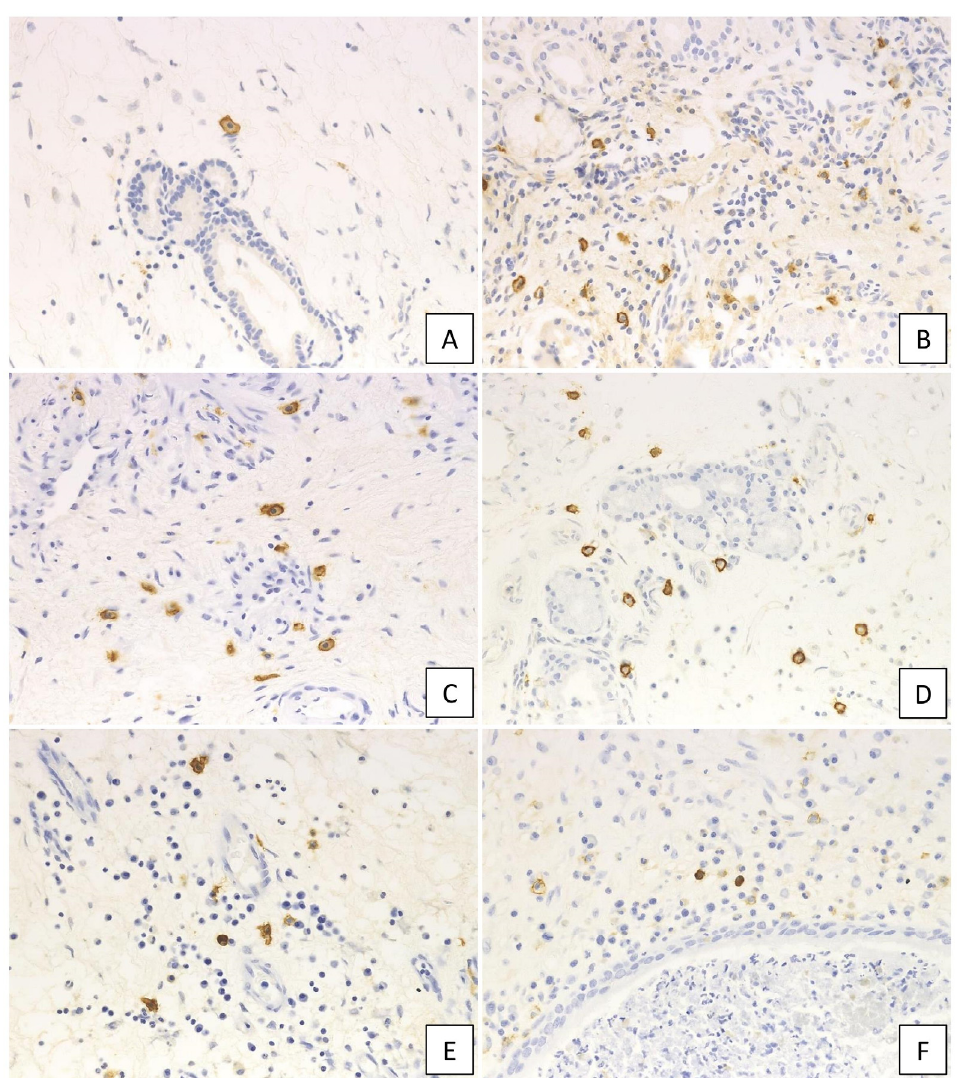
Figure 4. Immunohistochemical findings of IgE in the diseased tissue. ( A ) non-CRS, ( B ) CRSsNP, ( C ) non-ECRS, ( D ) mild ECRS, ( E ) moderate ECRS, and ( F ) severe ECRS. IgE-positive cells increased in the diseased tissue (400 × magnification).